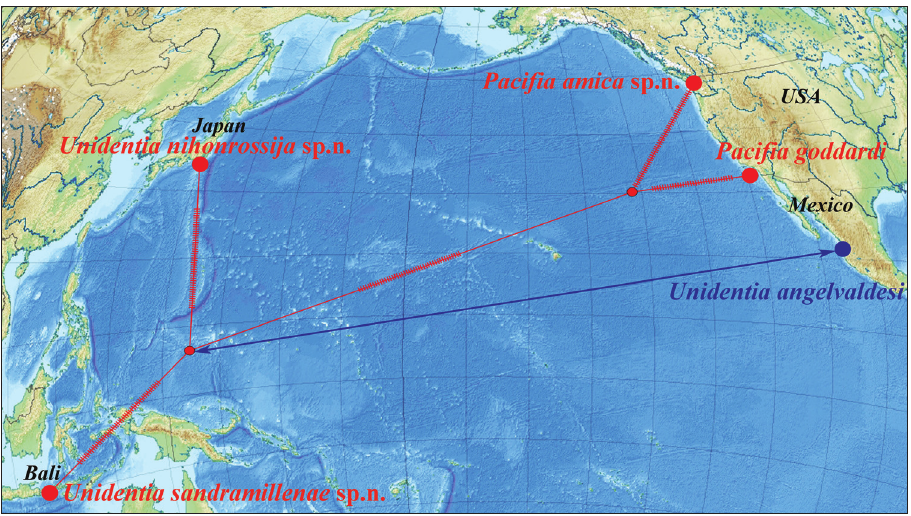
Figure 44. Haplotype network based on molecular data COI for the taxa of the family Unidentiidae (red lines) superimposed on the map of the Pacific Ocean. Predicted relationship between Unidentia an- gelvaldesi and other Unidentiidae is indicated by blue